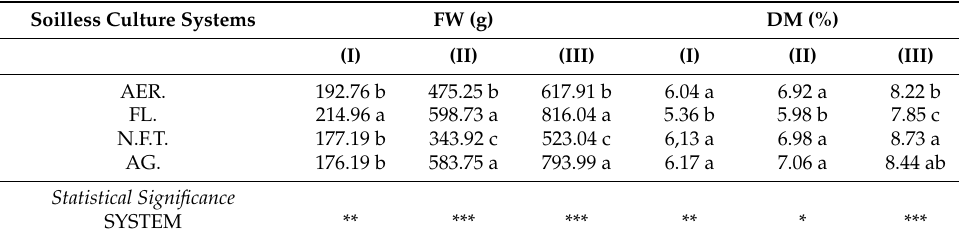
Table 4. Impact of CSCS on plant (i) fresh weight (FW—g) and (ii) on % dry matter (% DM) during the 3 samplings (I, II, III), i.e., 31, 62, and 95 days after transplant. Soilless Culture Systems